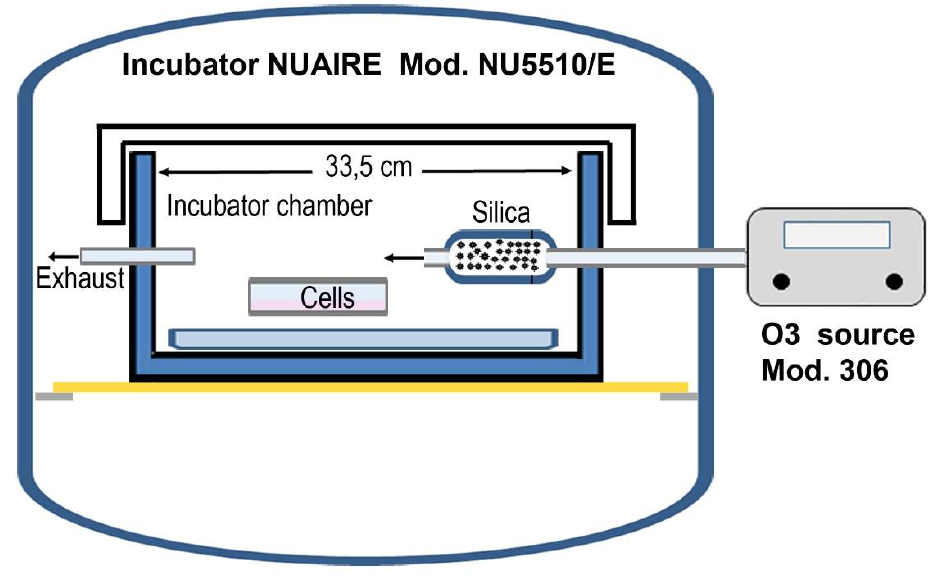
Figure 1. Schematic illustration of the exposure system.